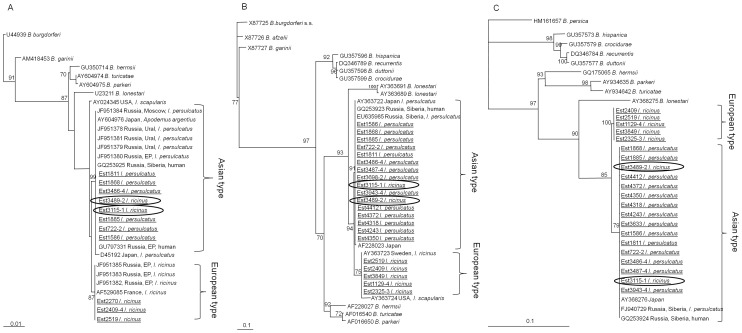
Phylogenetic trees based on the partial sequences of 16S rRNA, p66 and glpQ genes.The Maximum Likelihood model was used for phylogenetic tree reconstruction of the partial A) 16S rRNA (1106 bp), B) p66 (349 bp and 355 bp for “I. persulcatus”-type and “I. ricinus”-type, respectively) and C) glpQ genes (379 bp). Only quartet puzzling support values >70% are shown. Samples sequenced in the present study are underlined.